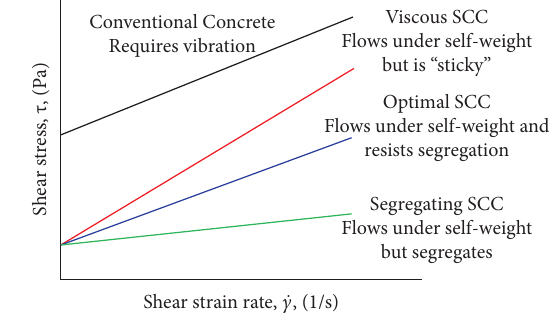
Figure 1: Flow curves